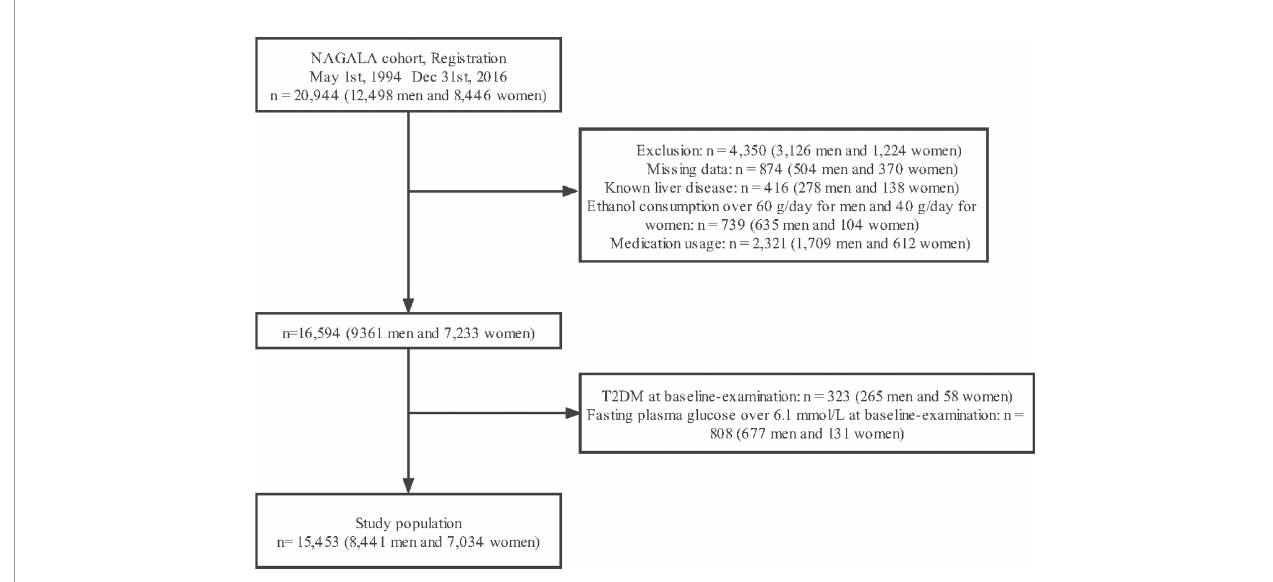
FIGURE 1 | Flowchart of participant